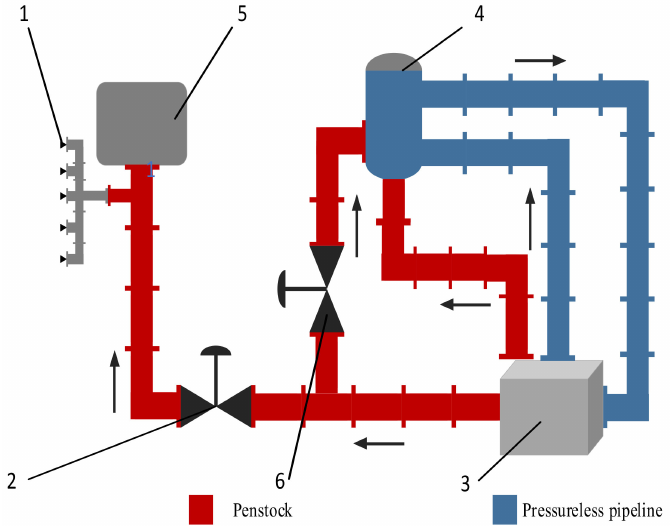
Figure 12. Nonlinear variable spray system. 1: Nozzle; 2: Electric on–off valve; 3: Pump; 4. Medicine box; 5: Pressure sensor; 6: Electric proportional valve. (The black arrow in the figure shows the flow direction of the aqueous